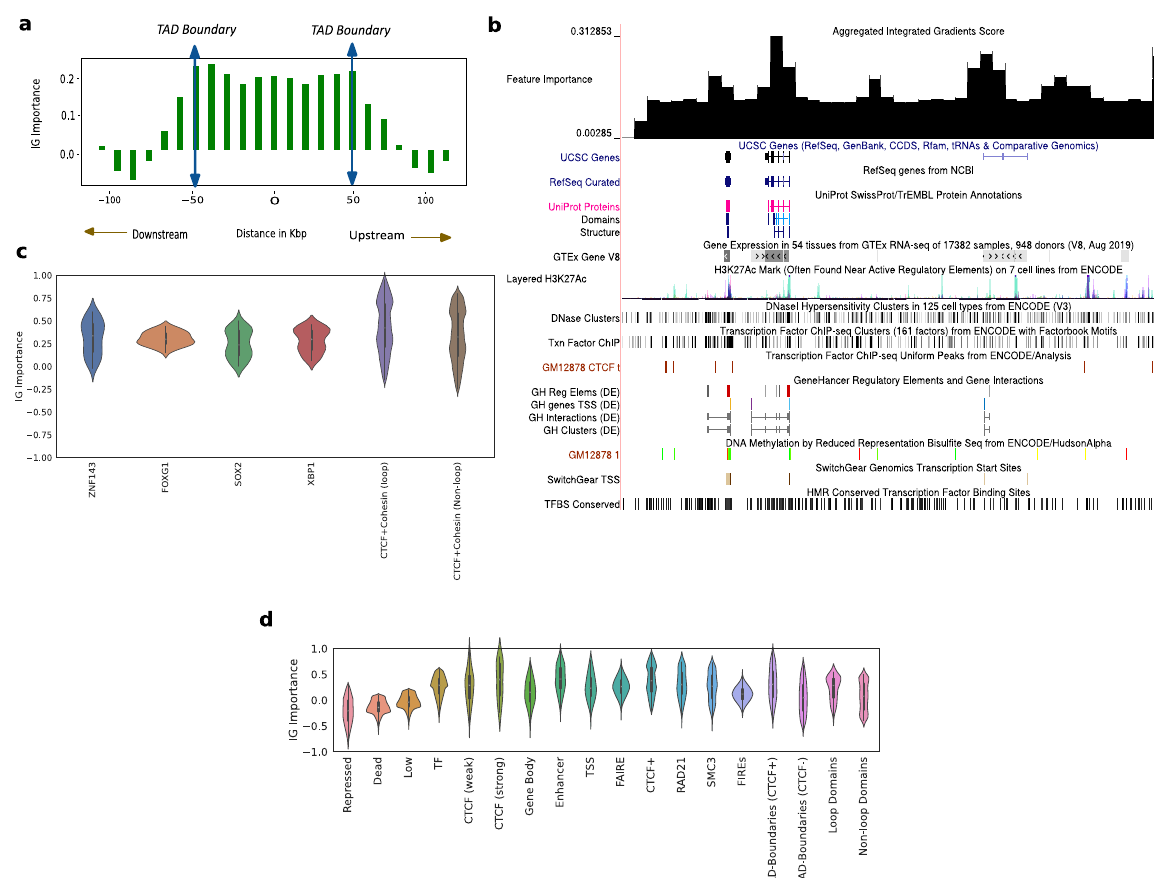
Fig. 6 Hi-C-LSTM representations identify genomic elements involved in conformation through integrated gradients (IG) feature importance analysis. a The IG feature importance averaged across different TADs of varying sizes. The vertical axis indicates the average IG importance at each position and the horizontal axis refers to relative distance between positions in kbp, upstream/downstream of the TADs. b The IG feature importance for a selected genomic locus (chr21 28 – 29.2 Mbp) along with genes, regulatory elements, GC percentage, CTCF signal, and conserved TFBS among others in the UCSC genome browser. We see that the feature importance scores peak at known regulatory elements, higher GC percentage, and CTCF peaks. c Violin plots of aggregated feature attribution scores for top ranked transcription factor binding sites (TFBS). The x -axis shows the labels/elements and the y -axis displays the z normalized feature importance scores from Integrated Gradients. Both at loop and non-loop regions, the scores shown are aggregated only at shared sites. d Violin plots of aggregated feature attribution scores for selected elements. The x -axis shows the labels/elements and the y -axis displays the z normalized feature importance scores from Integrated Gradients. The scores for CTCF and Cohesin subunits are aggregated genome wide. In c , d , Violin plots present summary statistics where the white dot is the median, thick gray bar is the inter-quartile range, and thin gray line is the rest of the distribution. Kernel density estimation is shown on either side of the line. Sample size for the genomic elements are calculated genome wide by considering all observations of elements according to element speci fi c